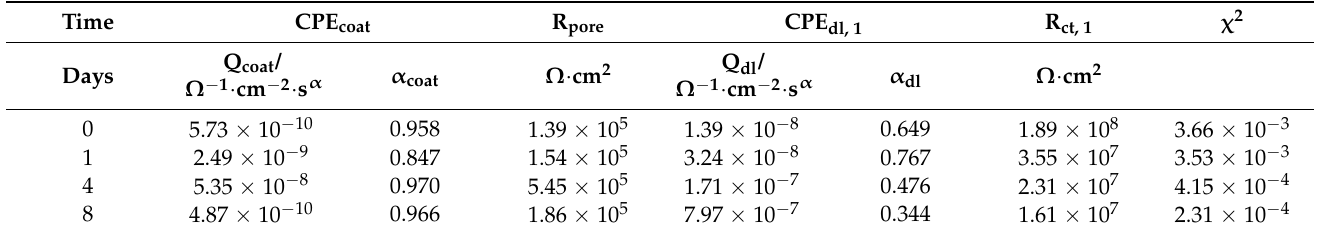
Table 4. Fitted values of EEC components for a coating prepared from the formula Zn–80%-PC, Stage 1.